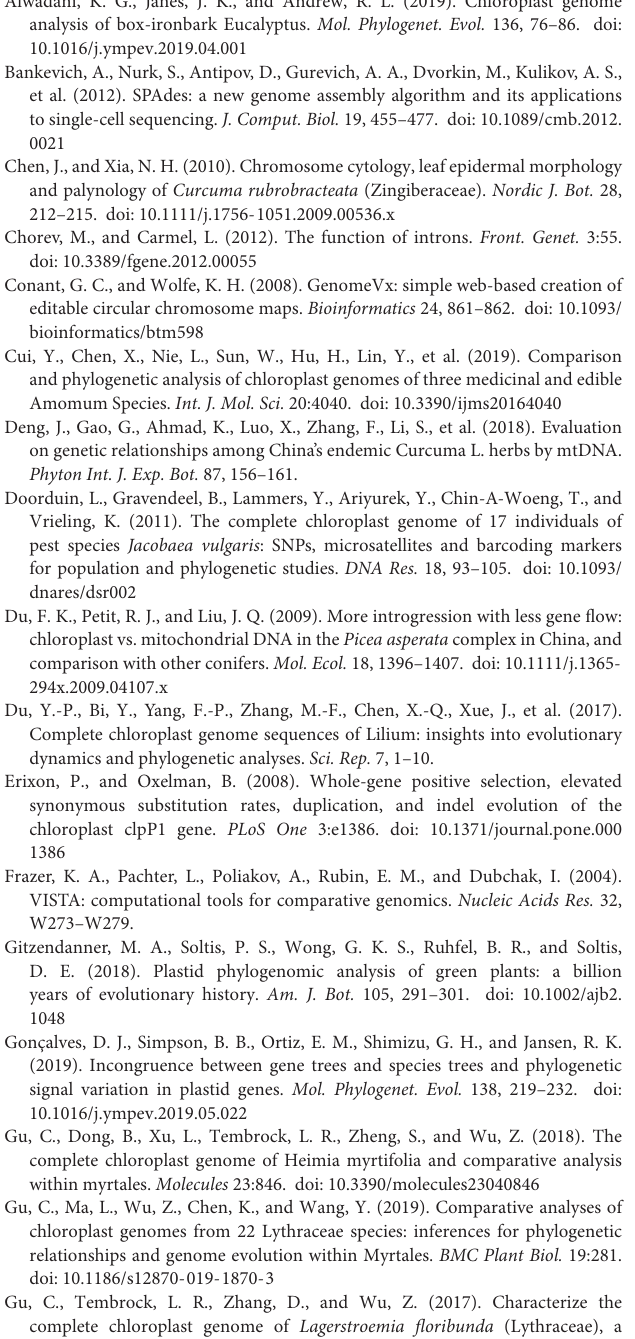
TABLE S6 | The comparison of Long repeats among 25 Zingiberaceae species. TABLE S7 | The comparison of SSRs among 25 Zingiberaceae species. TABLE S8 | The Pi value of 14 Curcuma species. TABLE S9 | The GenBank accession numbers of 56 species using in phylogenetic